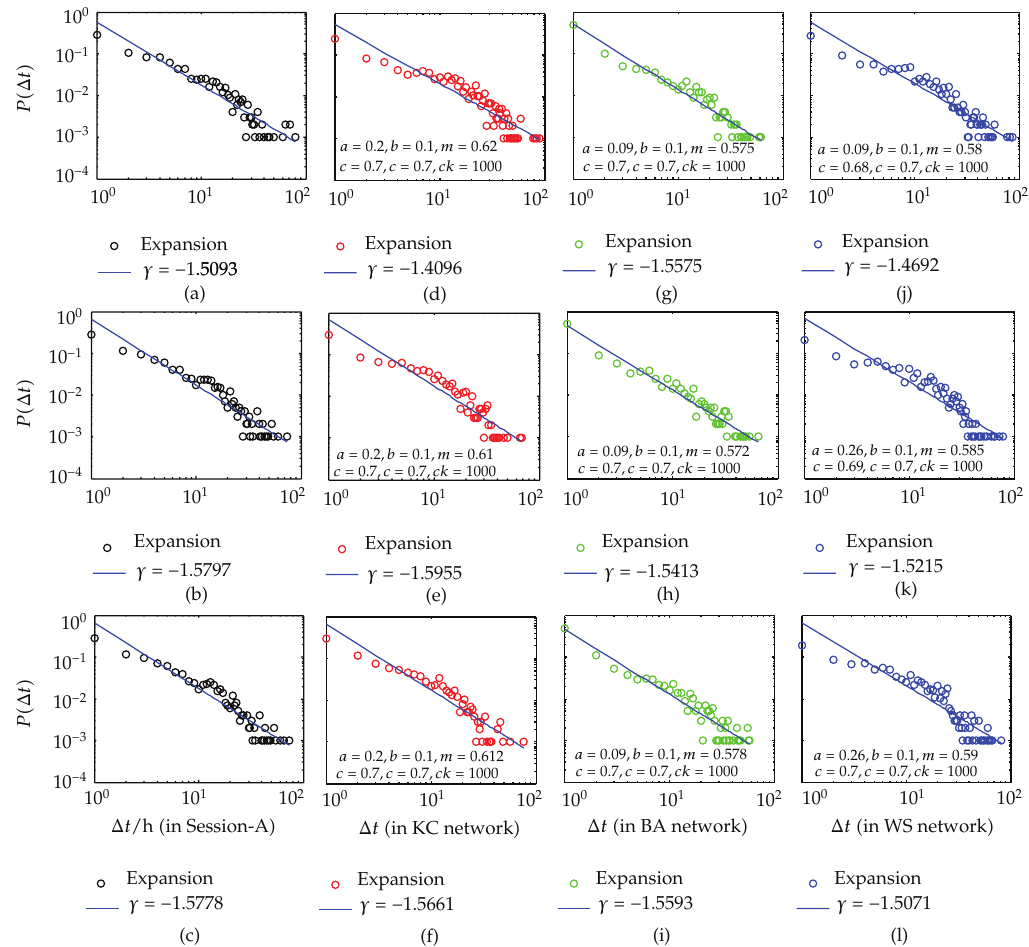
Figure 3: Comparing empirical results with simulation results. Figure 3 (cid:2) a (cid:3) –3 (cid:2) c (cid:3) with black color are the same in Figure 1 (cid:2) a (cid:3) –1 (cid:2) c (cid:3) . Figure 3 (cid:2) d (cid:3) –3 (cid:2) f (cid:3) with red color are the simulation results on the KC network. Figure 3 (cid:2) g (cid:3) –3 (cid:2) i (cid:3) with green color are the simulation results on the BA network. Figure 3 (cid:2) j (cid:3) –3 (cid:2) l (cid:3) with blue color are the simulation results on the WS network.